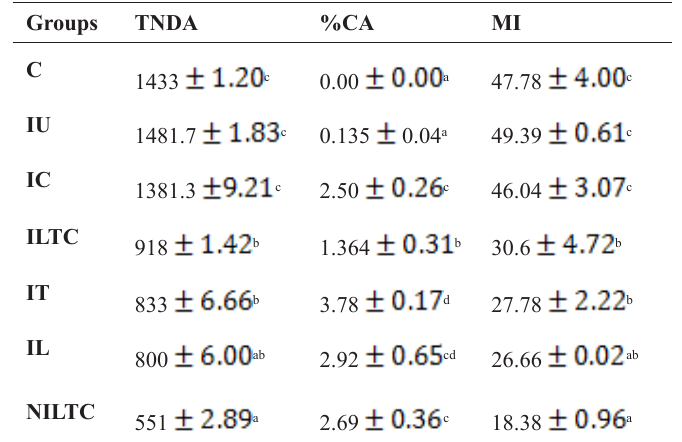
Table 5: Effects of administration of lumefantrine, trimethoprim and lumefantrine-trimethoprim-copper complex on the metaphasic status of chromosomes of the liver of P. berghei NK-65 infected mice.